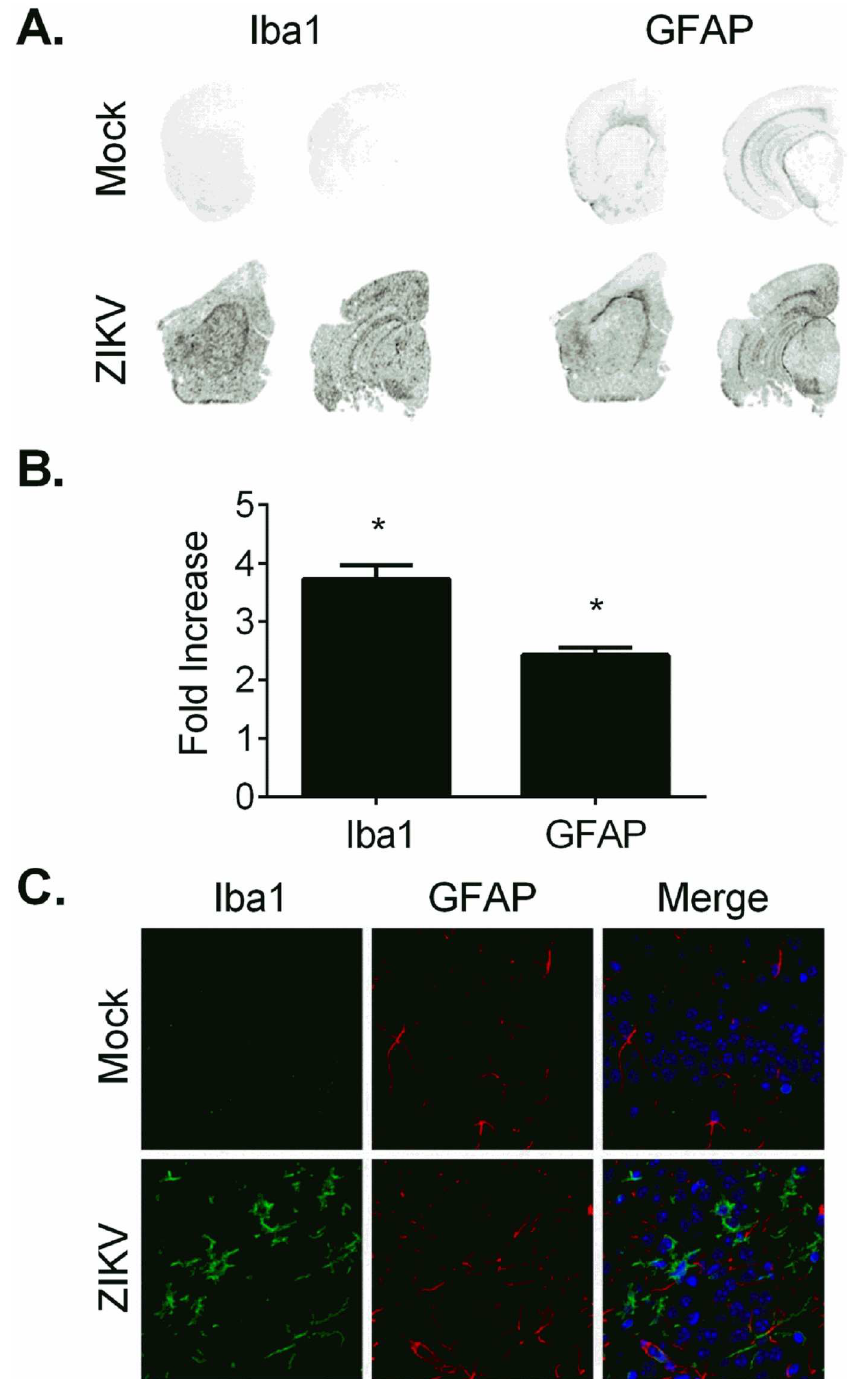
Fig 6. Iba1 and GFAP are Increasedin the Brains of ZIKV-Infected Wild-type Mice Treated with an IFNAR1-Blocking MAb. (A-B) Brain sectionsfrom mice treated with IFNAR1-blocking MAb and infected with ZIKV or mock infected with PBS were imagedand analyzedby infrared imaging.Representative images showedincreasedIba1 and GFAP stainingin brain sections from ZIKV-infected mice comparedto PBS- inoculated mice. (B) The averageinfrared intensity, expressedas fold increase relative to PBS, was significantly increasedin ZIKV-infected mice comparedto PBS-inoculated mice for both Iba1 (PBS: 0.9929 ± 0.1614, n = 5; ZIKV: 3.725 ± 0.2415, n = 10; * p < 0.0001, t-test) and GFAP (PBS: 1.000 ±